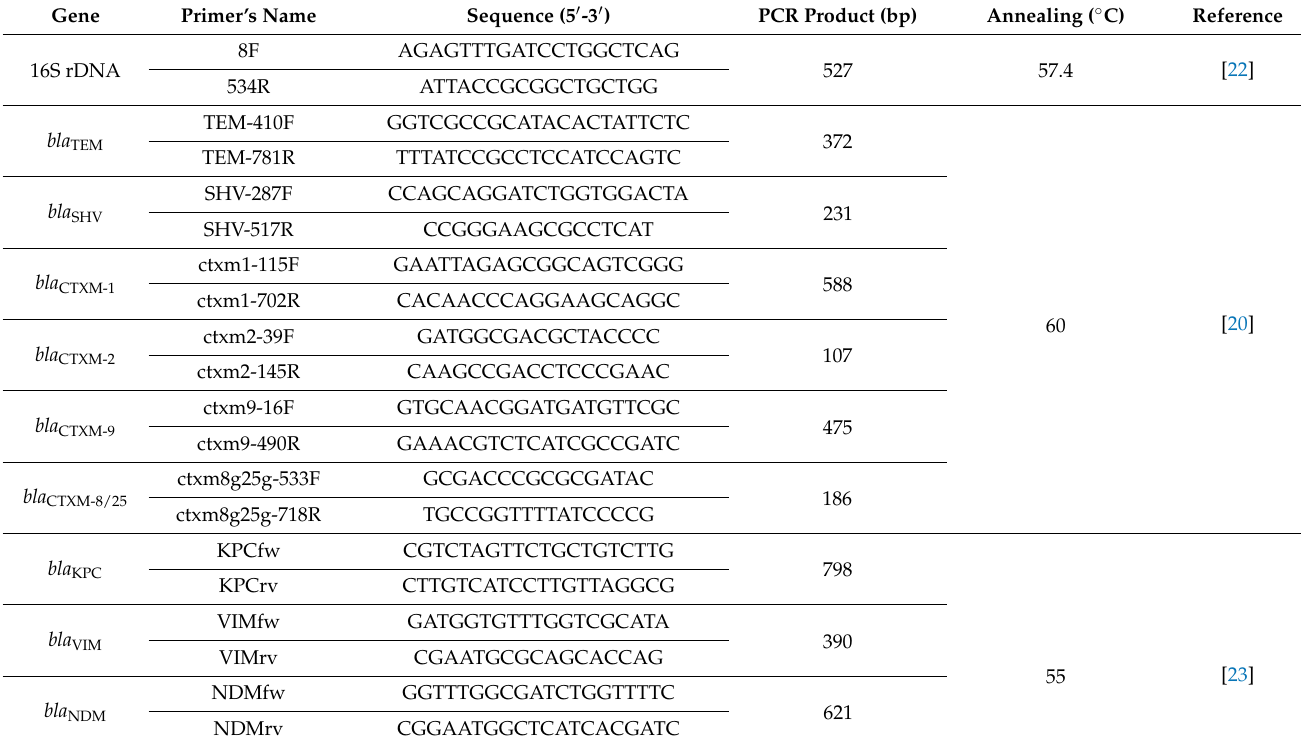
Table 1. List of primers used for molecular identification of β -lactam resistance genes from eDNA of QPT